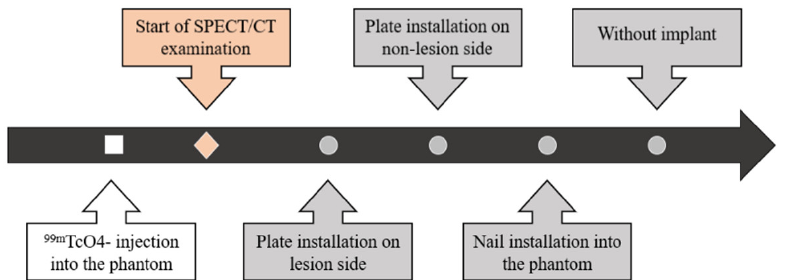
Figure 3. Flowchart of the imaging procedure. First, 99m TcO 4− was injected into the phantom. Next, the phantom was placed on the SPECT/CT imaging table and visualized after each modification, which were performed in the following order: plate installation on the phantom at the lesion side, plate installation contralateral to the lesion (i.e., on the non-lesion side), intramedullary nail installation, and implant removal.